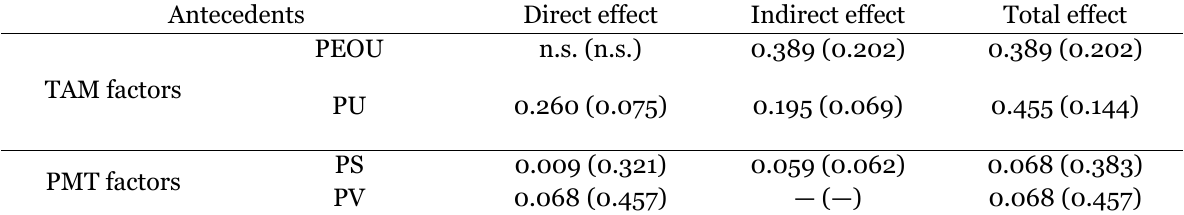
Anteceden ts’ Effect on ITTELC Between Vietnam and Taiwan Model